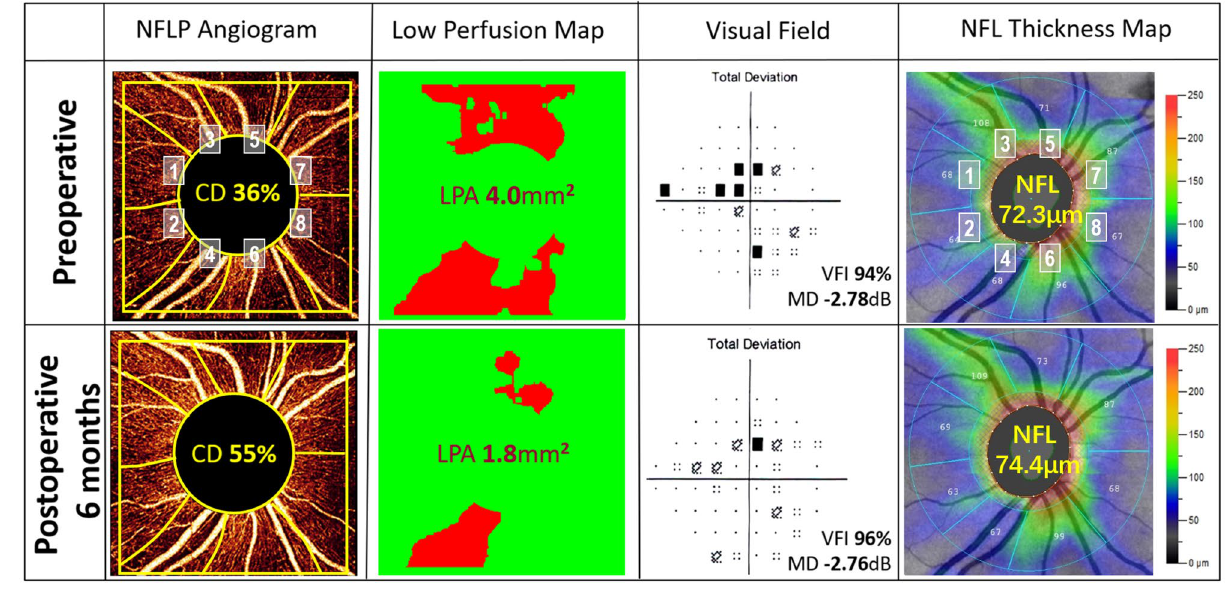
Figure 1. A mildly glaucomatous eye showed retinal perfusion recovery at 6 months after trabeculectomy. The nerve fiber layer plexus (NFLP) angiogram was divided into 8 corresponding sectors according to an extended Garway-Heath scheme. This participant had lower IOP (from 16 to 13 mmHg) and less ocular antihypertensive medications use (from 3 to 0) at 6 months postoperatively. The NFLP capillary density (CD) increased by 53%. The low-perfusion map showed the perfusion defects mainly in the sector 3, 4, 5 and 6. The low-perfusion area (LPA) became 55% smaller after surgery. The perfusion recovery occurred primarily in the sector 3 and sector 6, where the NFL thickness were less thinning than the sector 5 and sector 4. The visual field (VF) total deviation map showed shallower defects. The rim area increased from 1.10 to 1.21 mm 2 and the cup/disc area ratio decreased from 0.30 to 0.27. However, the VF mean deviation (MD) and nerve fiber layer (NFL) thickness showed minimal